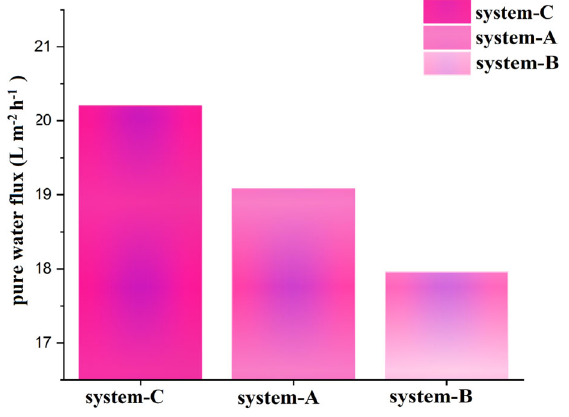
Fig. 8 Pure water fl ux for the OH channel in the studied